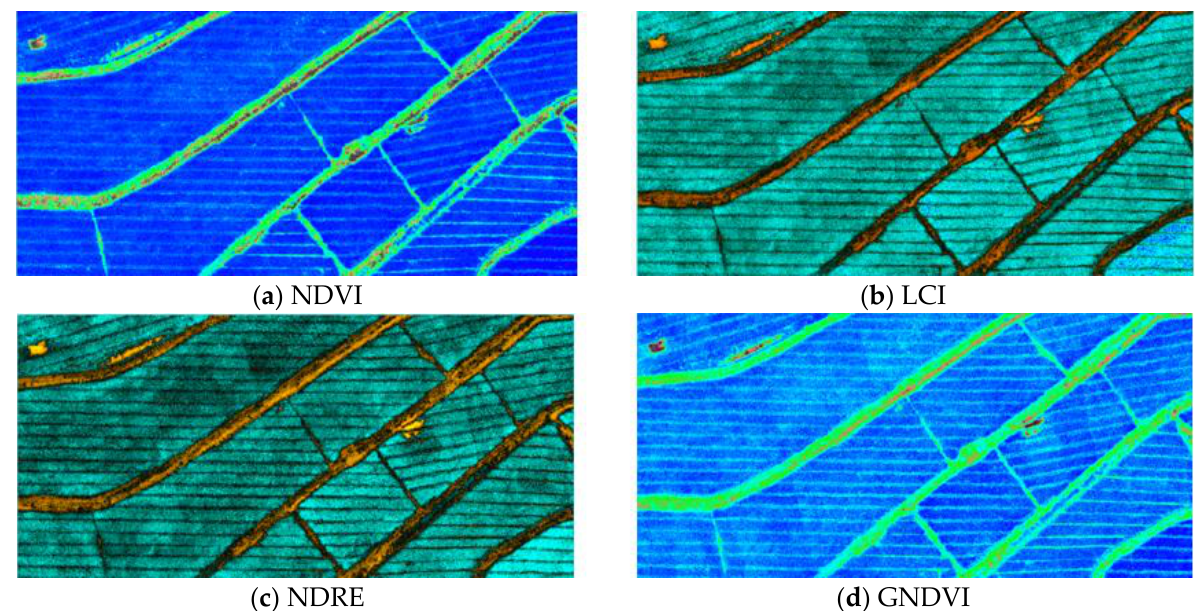
Figure 3. Calculation results for six visible light vegetation indices.